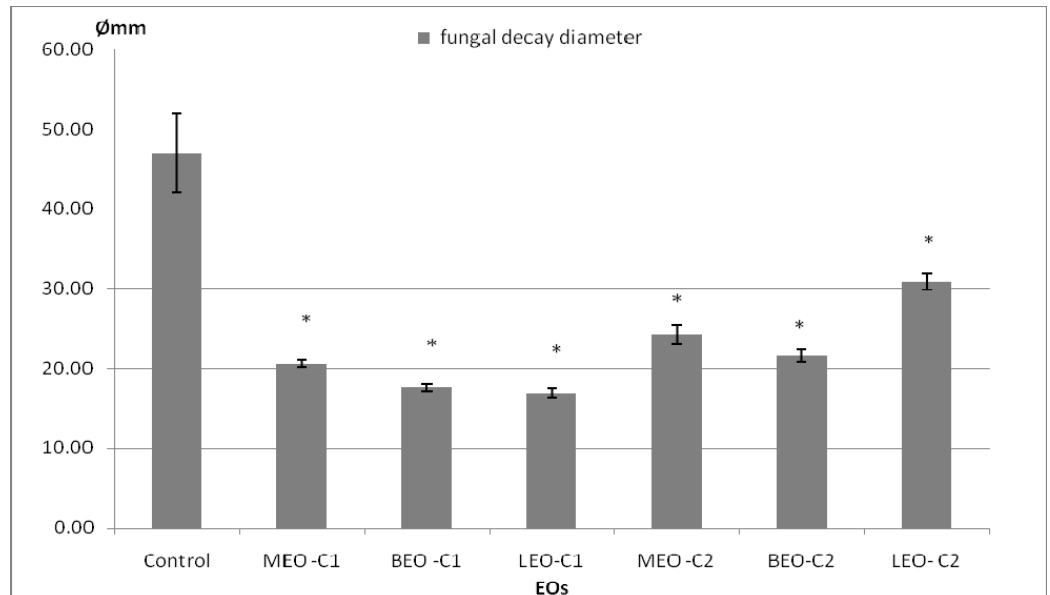
Figure 2. Results of lemon depreciation inoculated with P. digitatum stored seven days in the modified atmosphere with EO vapor . Data represent the diameter (mm) affected by the fungal growth with or without reproductive structure presented as mean ± SD. Vertical bars represent standard deviations ( n = 8); * with statistical differences compared to control at p < 0.05; MEO ‐ C1 = 183 μ L ∙ L − 1 , BEO ‐ C1 = 46 μ L ∙ L − 1 , LEO ‐ C1 = 86 μ L ∙ L − 1 , MEO–C2 = 91.5 μ L ∙ L − 1 , BEO ‐ C2 = 23.0 μ L ∙ L − 1 , LEO ‐ C2 = 43.0 μ L ∙ L − 1 .